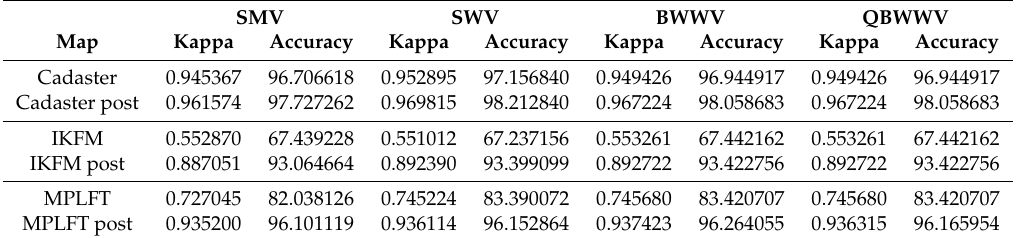
Table 4. Values of Kappa and accuracy (% observed correct) for the classification of the cadaster map, the Italian Kingdom Forest Map (IKFM) and the Map of the Potential Limit of the Forest in Trentino (MPLFT) with the four voting systems, Simple Majority Vote (SMV), Simple Weighted Vote (SWV), Best-Worst Weighted Vote (BWWV), Quadratic Best-Worst Weighted Vote (QBWWV), pre and post the application of the r.fill.category module.